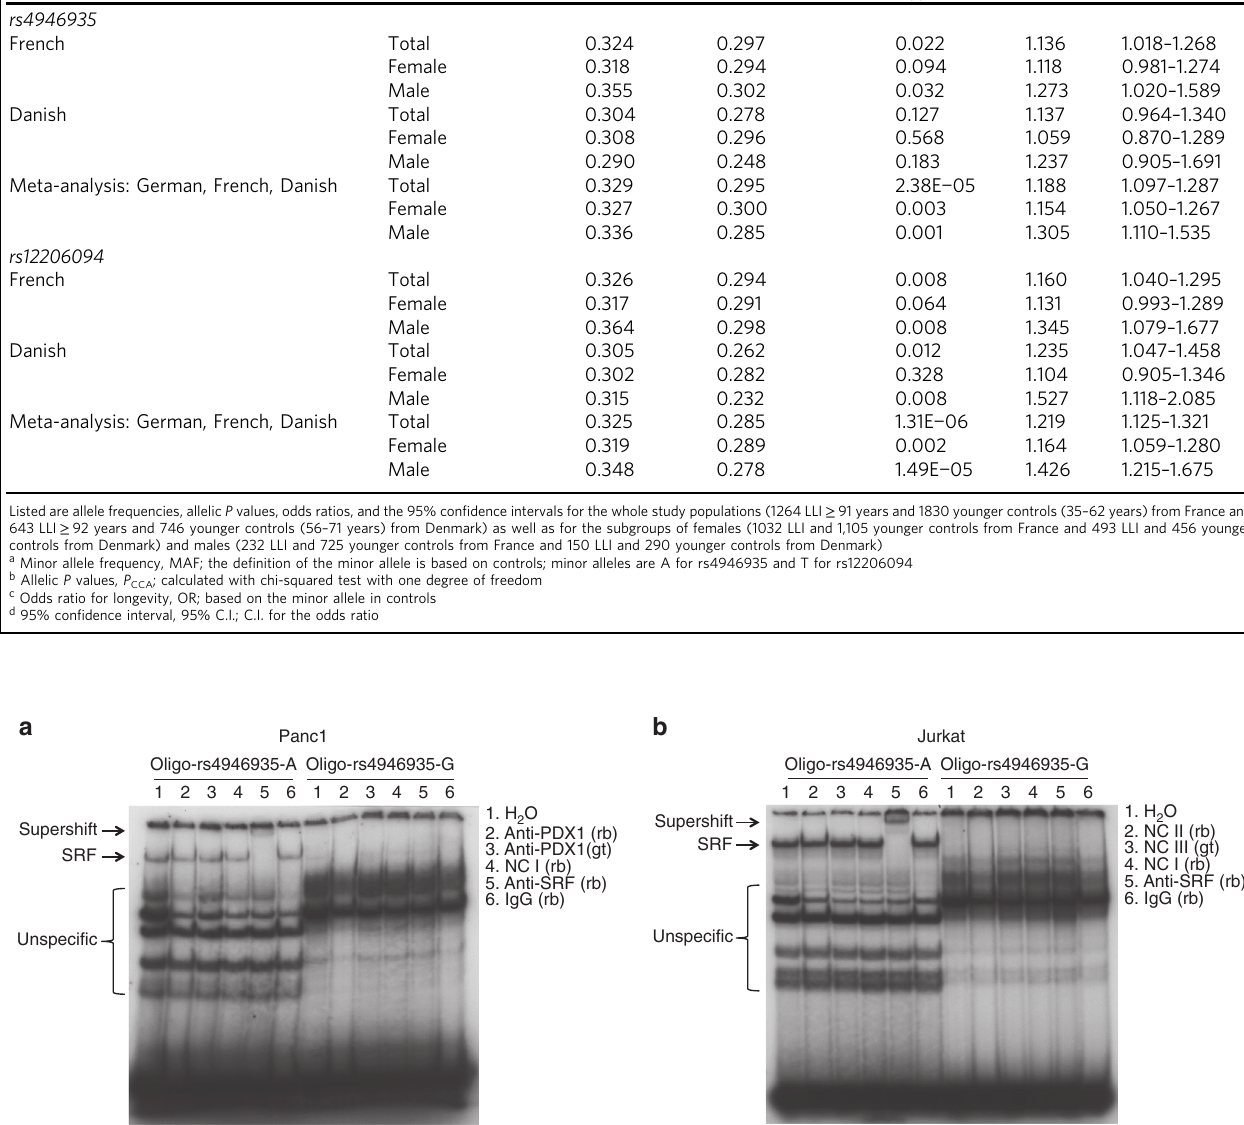
Table 3 Association statistics for the SNVs rs4946935 and rs12206094 in the French and Danish replication cohorts, respectively SNV